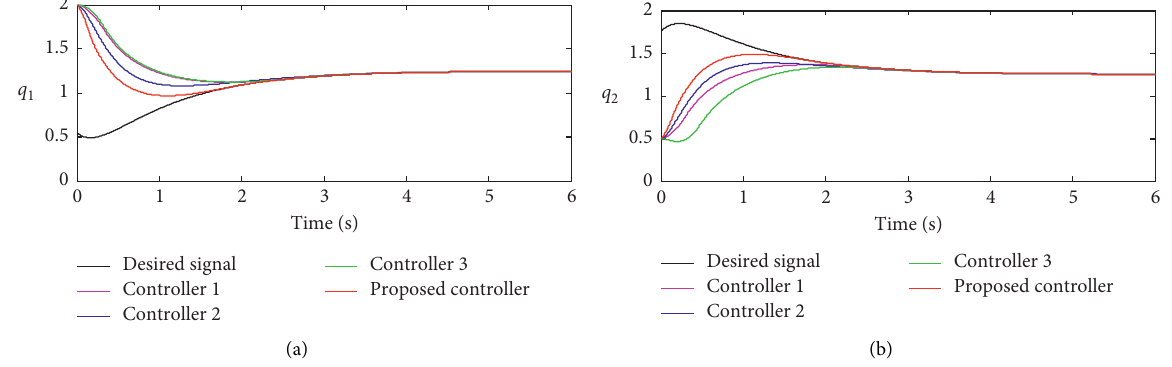
Figure 11: Position tracking performance under four controllers.